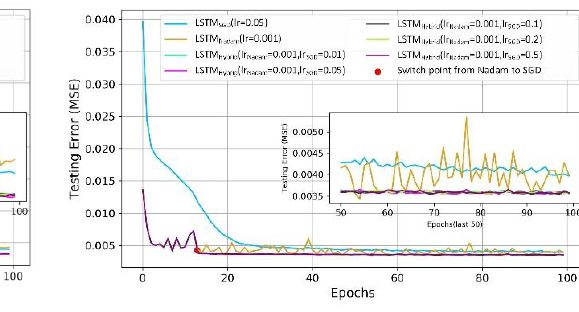
( a ) Convergence curves of the LSTM SGD , the LSTM Nadam and the LSTM Hybrid models (lr Nadam = 0.002).